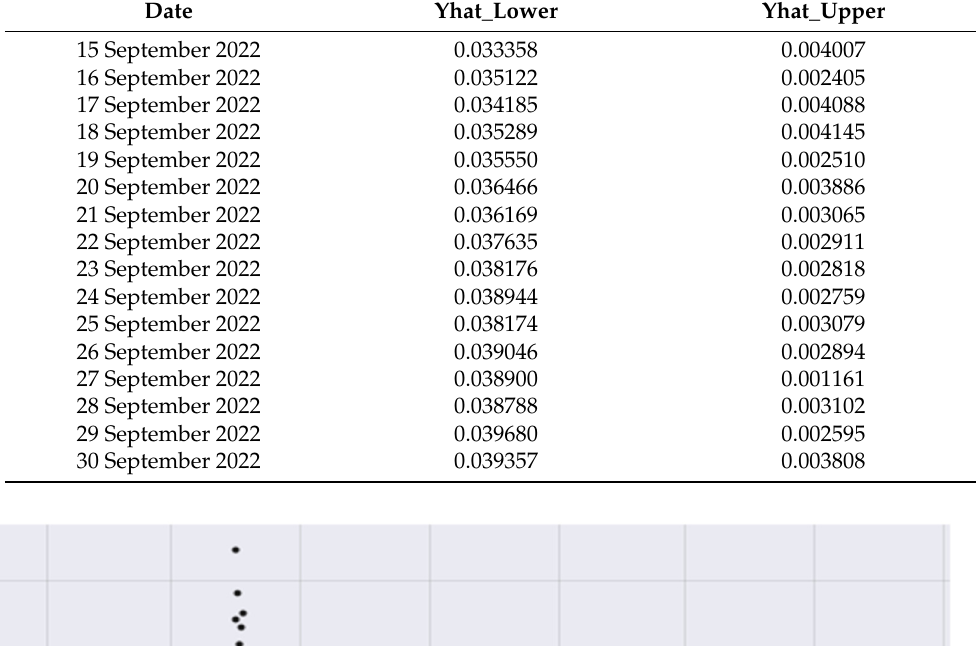
Table 4. Results of the AMP dataset for the last 15 days.